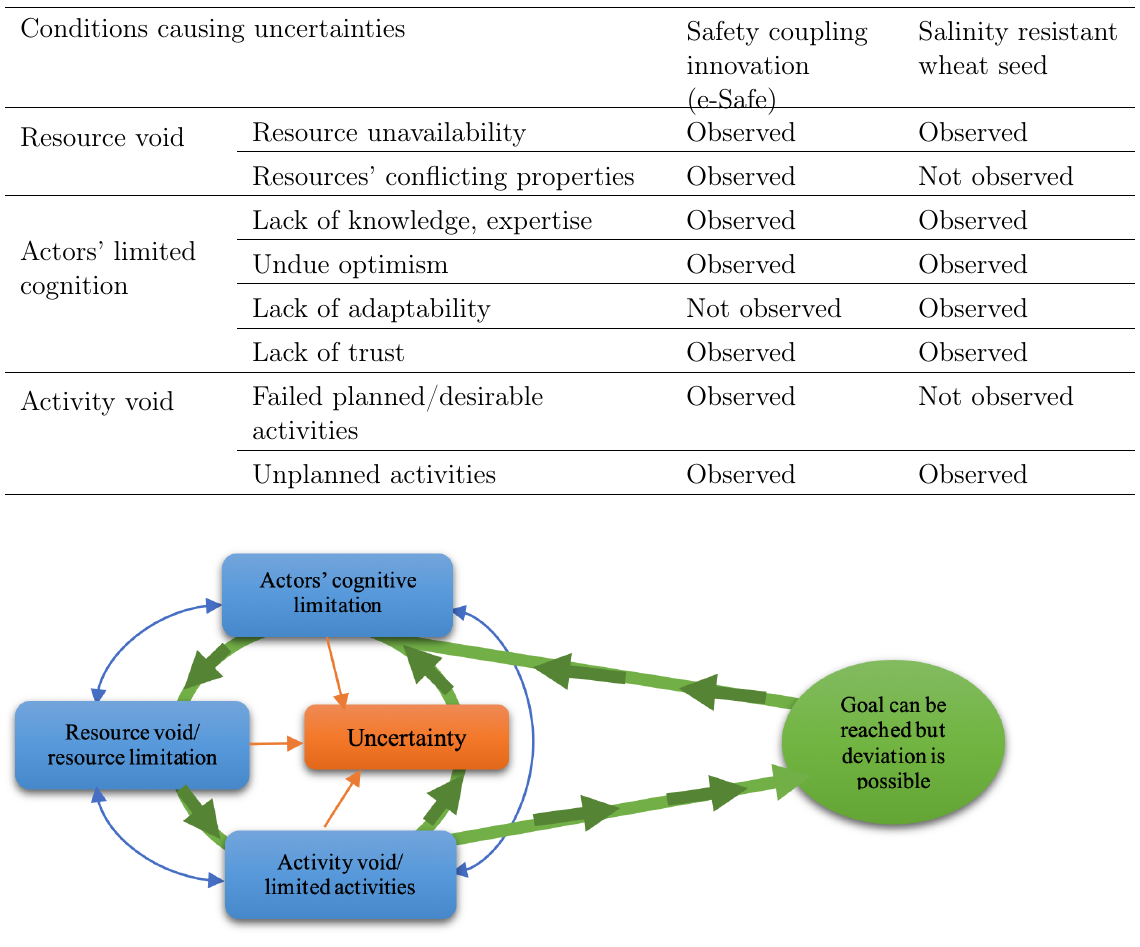
Fig. 2. How uncertainty emerged in the innovation process of e-Safe and SRHYWS (based on the